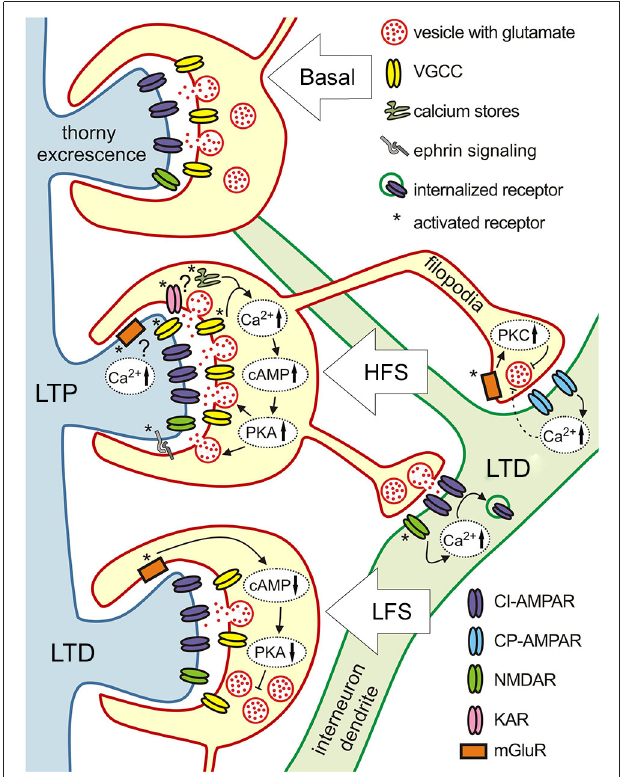
FIGURE 3 | Target-specific plasticity at three different types of MF synapses . Schematics illustration of the various molecular mechanisms underlying different forms of plasticity at MF synapses terminating on pyramidal cells (blue dendrite with thorny excrescencies) and inhibitory interneurons (green dendrite). High frequency stimulation induces LTP at pyramidal cell synapses that is NMDAR-independent and expressed presynaptically. Mechanisms involved are: increase in presynaptic calcium, adenylyl cyclase 1 (AC1), cAMP, protein kinase A (PKA), and ephrin signaling which up-regulate release machinery. At the presynaptic cite KARs and calcium release from stores might be involved, postsynaptic calcium increase due to the activation of mGluRs and VGCCs also might play a role. Same type of intense stimulation evokes LTD at filopodial synapses onto interneurons. At synapses expressing calcium-impermeable AMPARs (CI-AMPARs) LTD has a postsynaptic locus of induction and expression. It depends on calcium influx through NMDARs, and involves the endocytosis of surface AMPARs. LTD at synapses containing calcium-permeable AMPARs (CP-AMPARs) requires postsynaptic calcium increase, but is expressed presynaptically through activation of presynaptic mGluR7 and downstream Protein kinase C (PKC)-dependent cascades reducing neurotransmitter release probability. Low frequency stimulation evokes LTD at MF-pyramidal cell synapses. This form of LTD involves activation of presynaptic mGluR2, which in turn reduces cAMP level and